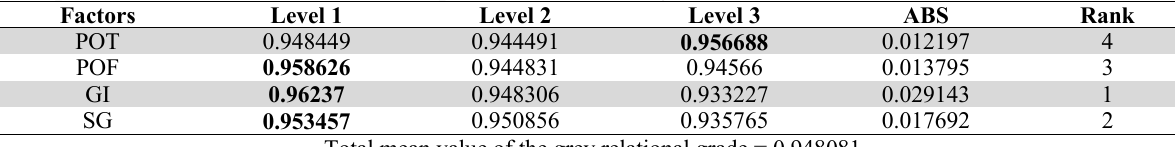
Response table for determination of optimum level